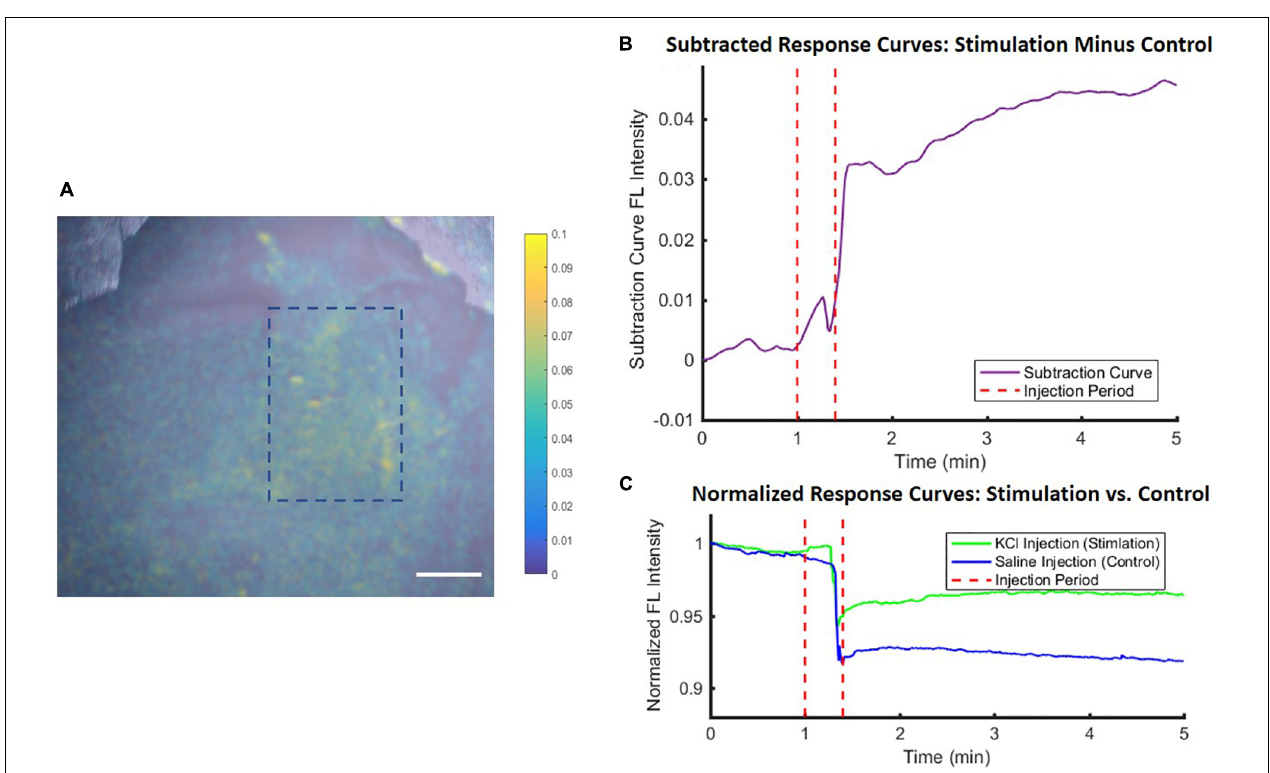
FIGURE 7 | In vivo experimental proof-of-concept results showed similar trends to ex vivo studies. Differences between stimulation (KCl) and control (saline) conditions were used to account for injection liquid scattering (A) in a fluorescence image for anatomical mapping overlaid with a colormap representing the difference between the conditions and quantified in (B) the subtracted time course fluorescence traces, with (C) showing the individual KCl and saline normalized response curves, all averaged over an ROI within the stimulation region [blue dashed rectangle in (A) ]. Scale bar = 4